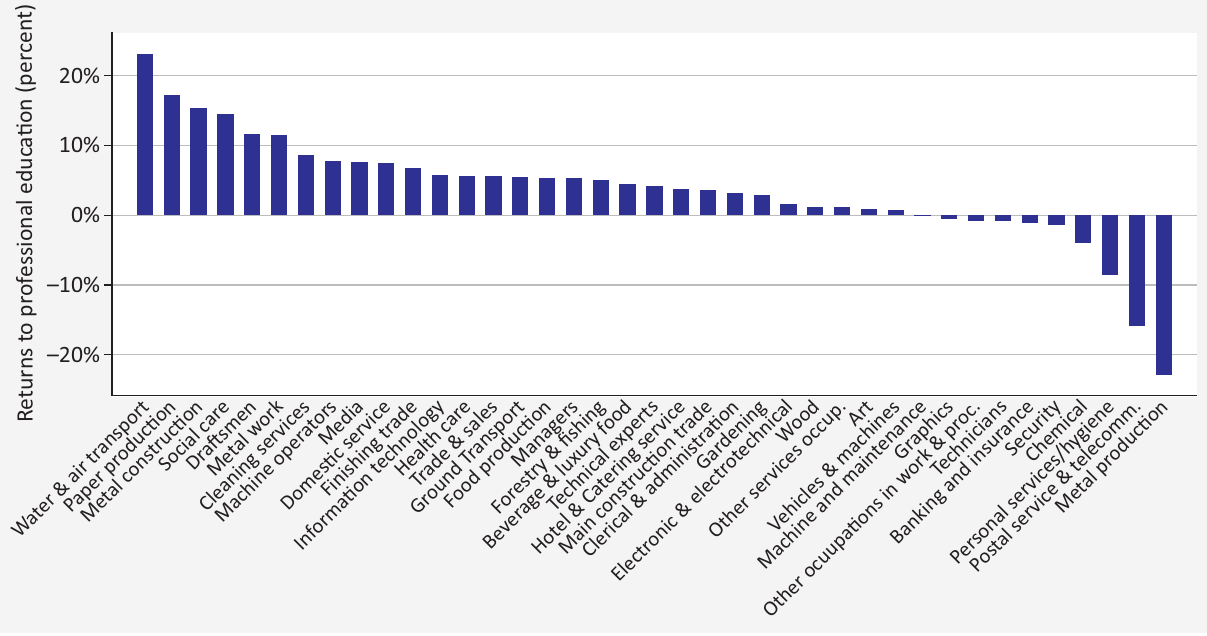
Figure 3. Mean return (%) to professional education by occupational